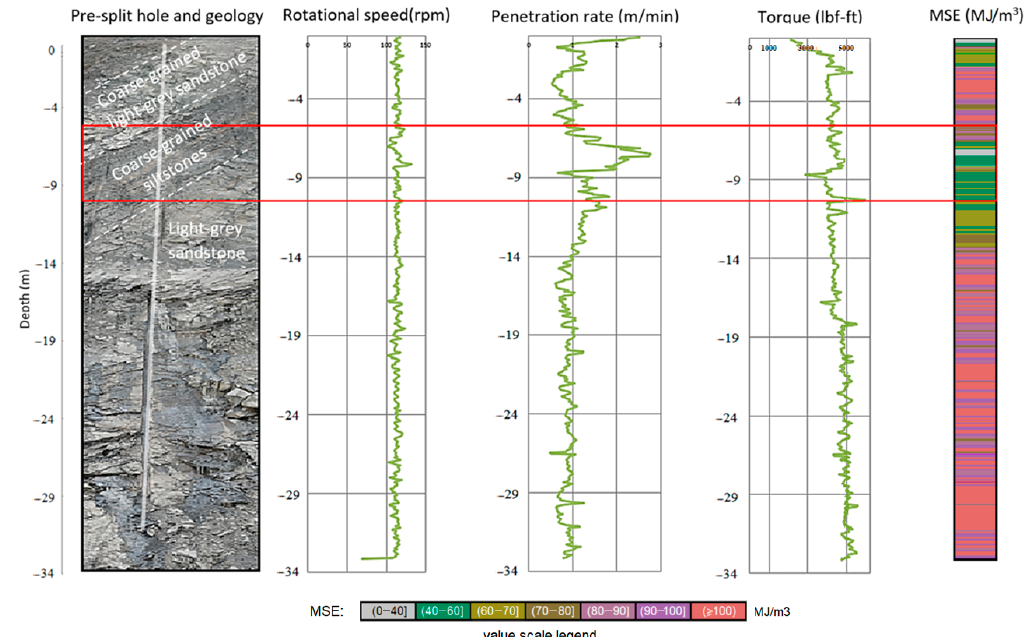
Figure 14. A dependence plot of MWD data on borehole depth for the borehole No. 475 in the block No. K 67–78.